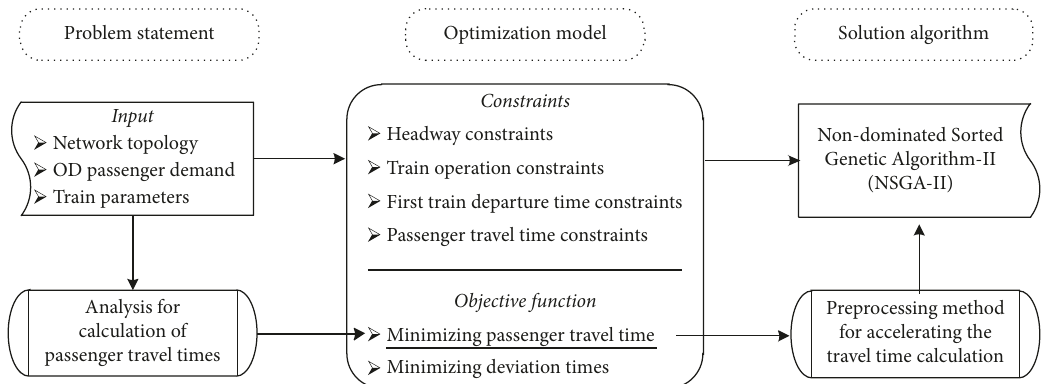
Figure 2: Illustration of the research process outline.